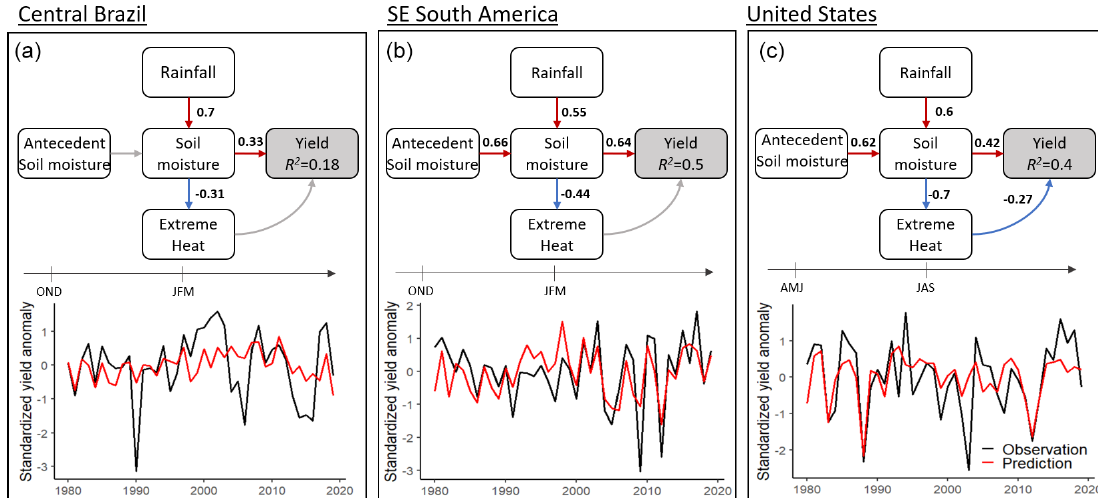
Figure 2. Structural equation models quantifying the impacts of hot and dry conditions on crop yields in central Brazil (a) , SE South America (b) and the United States (c) . Red arrows show positive significant relationships and blue arrows show negative significant relationships ( P < 0 . 05) between variables. Gray arrows show statistically insignificant relationships ( P > 0 . 05). Observed yield time series are displayed in black, and predicted yield time series are displayed in